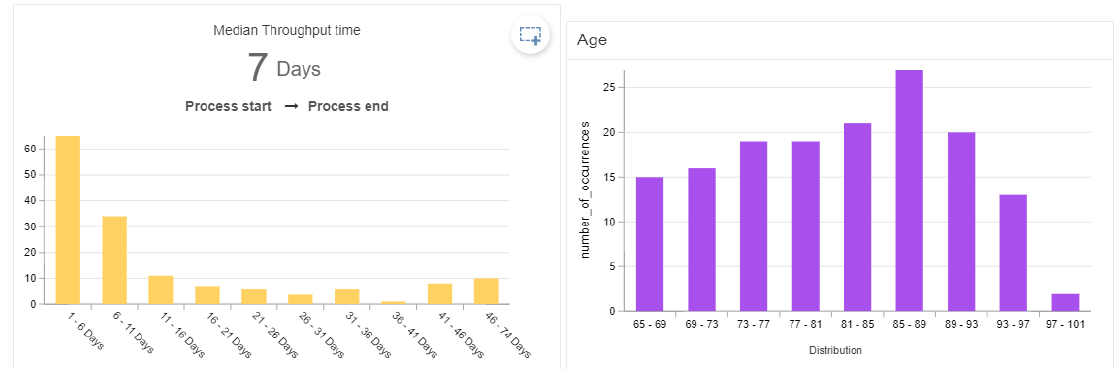
Figure 4. Length of stay of patients who were 65 years of age or